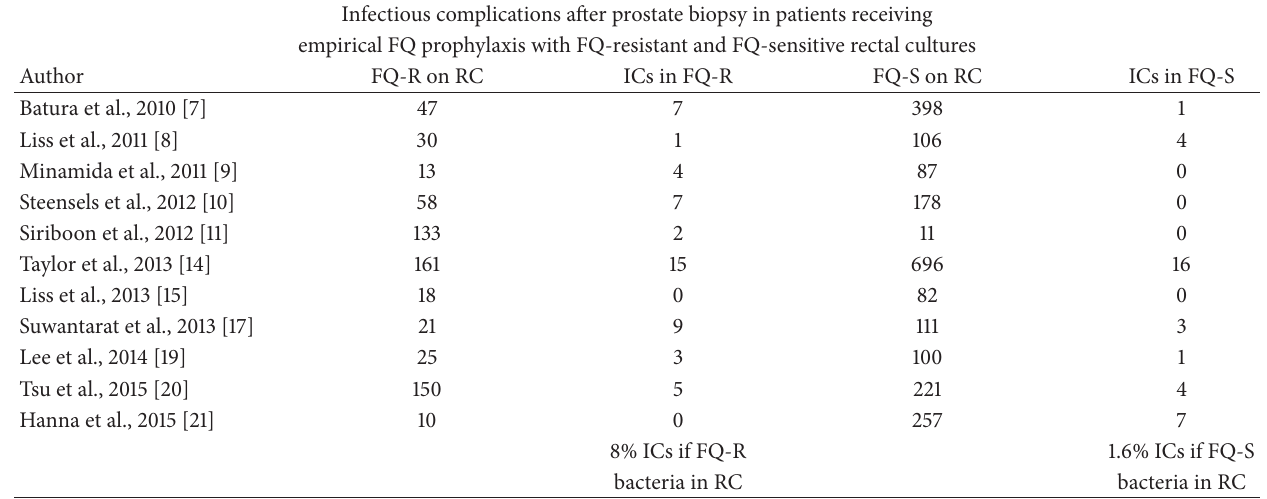
Table 1: Comparing infectious complications after prostate biopsy in patients with fluoroquinolone-resistant and fluoroquinolone-sensitive rectal cultures. (Empirical